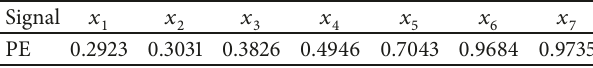
Table 1: PE values corresponding to different signals. Signal